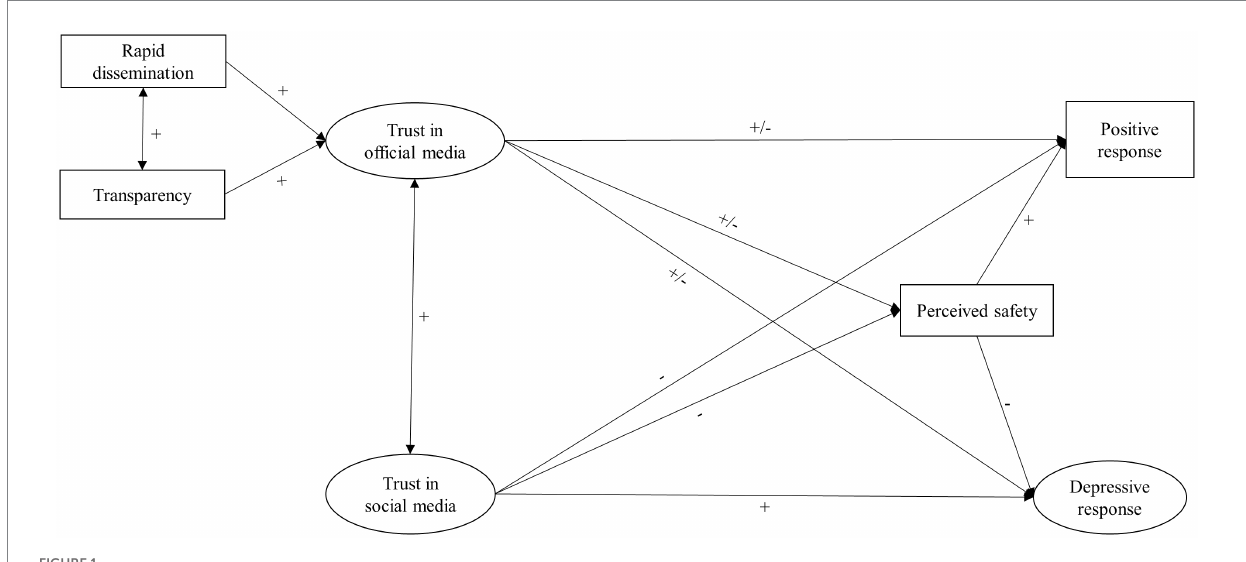
FIGURE 1 An integrative model to predict emotional responses toward the